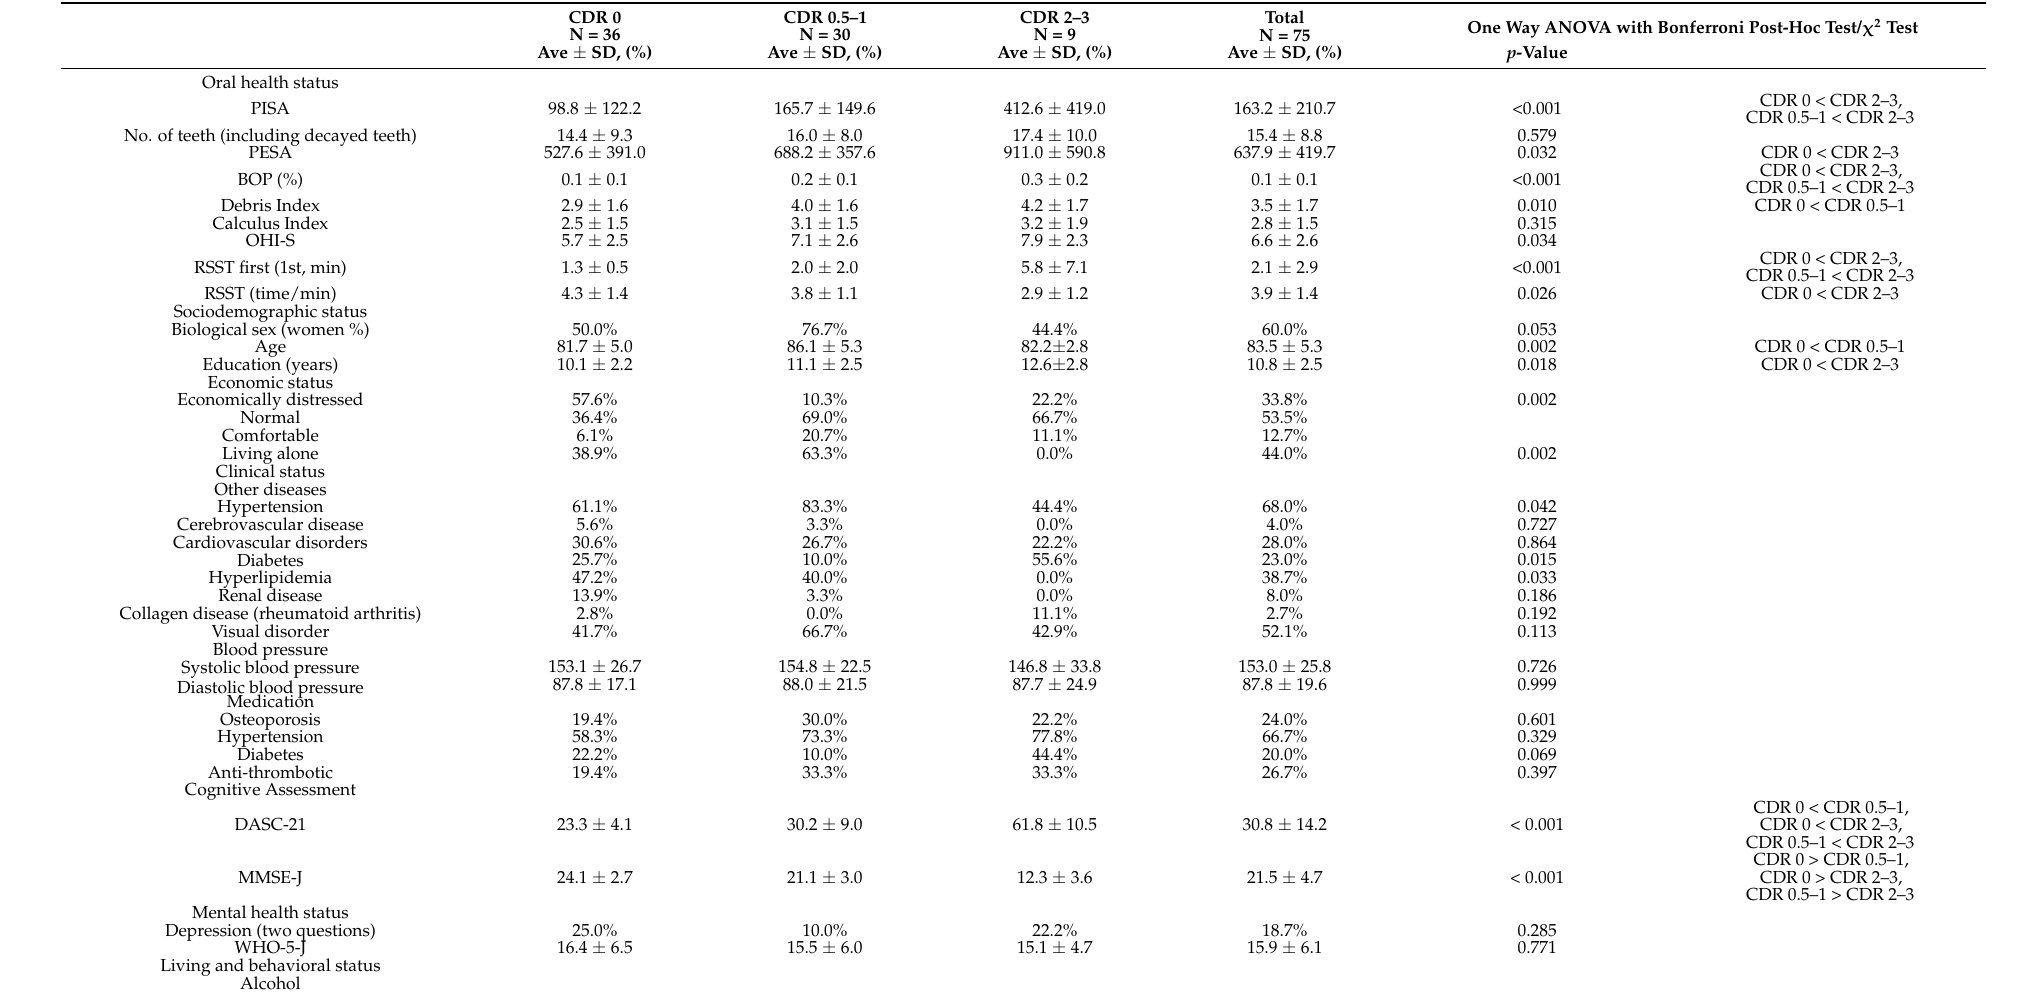
Table 1. Oral health status, sociodemographic status, and clinical and behavioral characteristics stratified by CDR